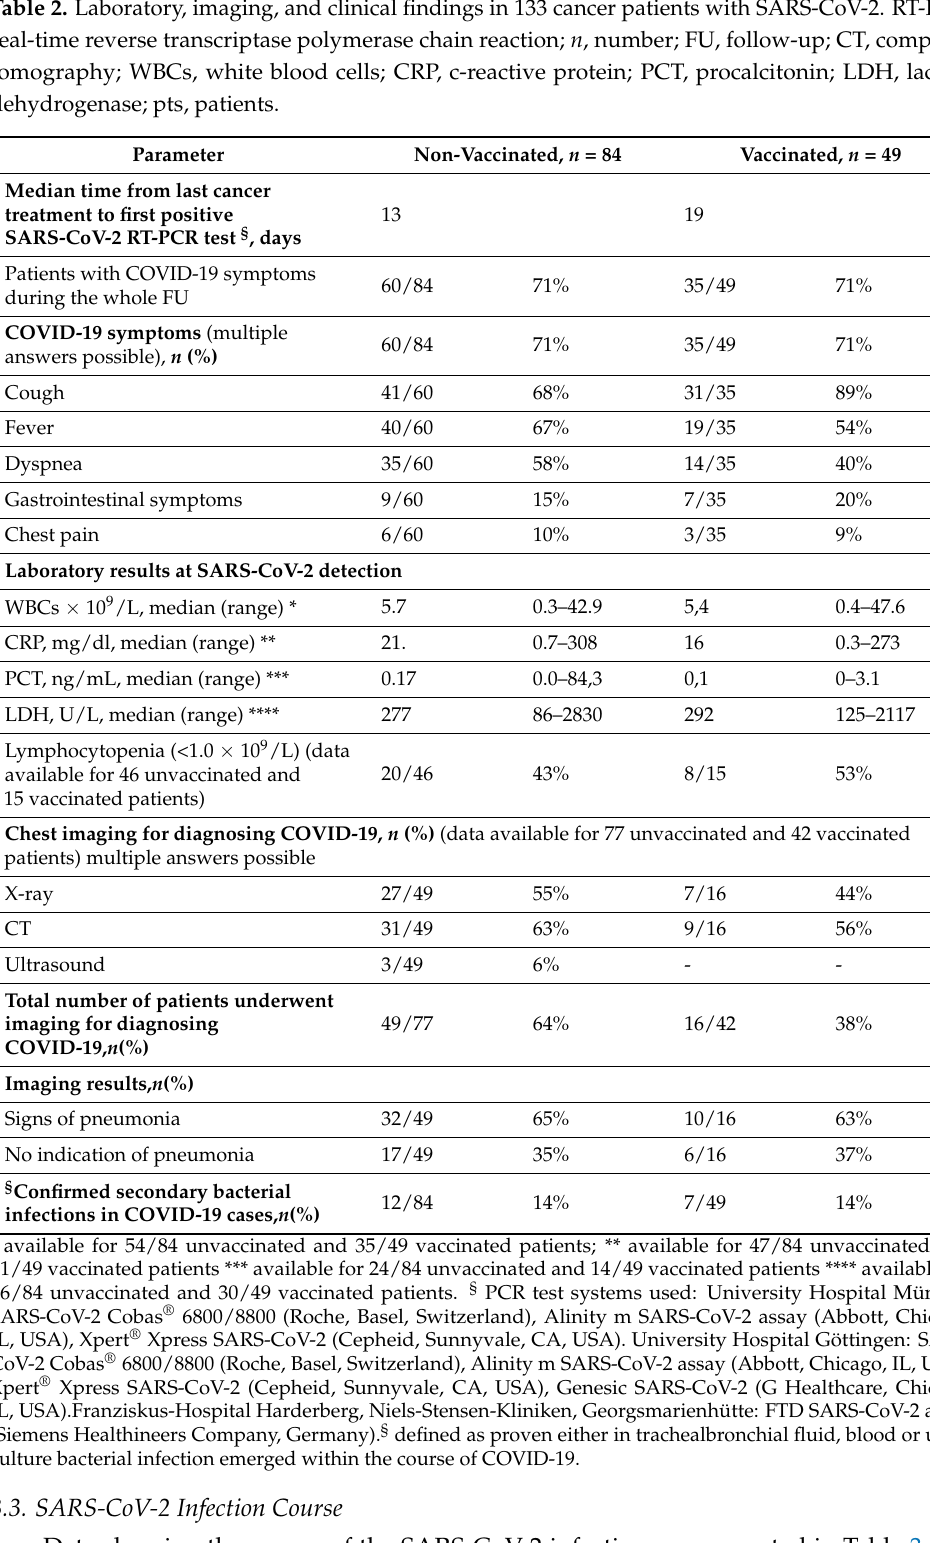
Table 2. Laboratory, imaging, and clinical findings in 133 cancer patients with SARS-CoV-2. RT-PCR, real-time reverse transcriptase polymerase chain reaction; n , number; FU, follow-up; CT, computer tomography; WBCs, white blood cells; CRP, c-reactive protein; PCT, procalcitonin; LDH, lactate dehydrogenase; pts, patients.